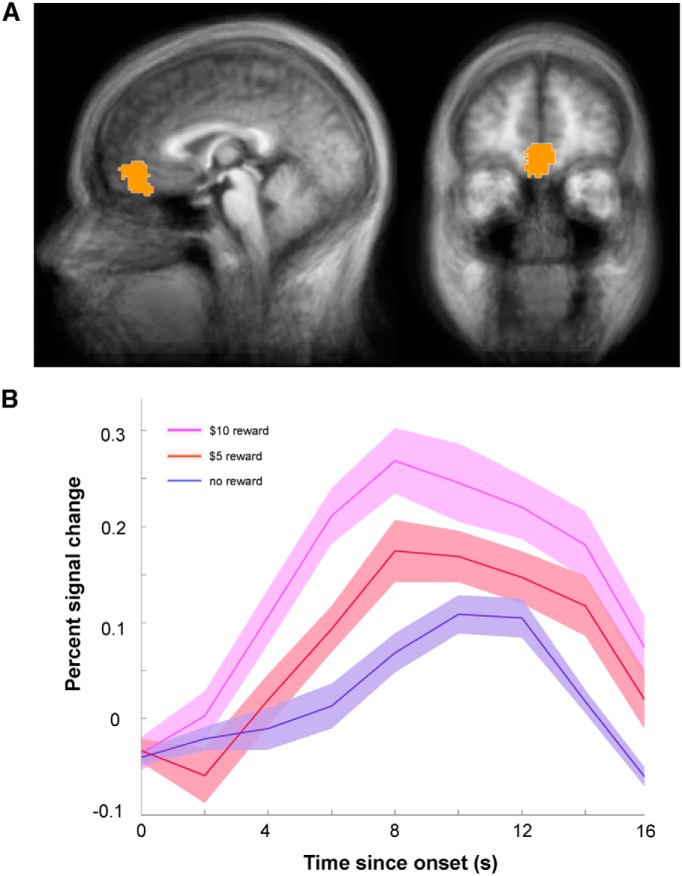
An independently defined value region in the vmPFC represents reward magnitude throughout the task. A, The spatial location of the external ROI. The ROI was reported by a meta-analysis on the valuation system in the human brain (Bartra et al., 2013) and made available through the authors’ website (http://www.psych.upenn.edu/kable_lab/Joes_Homepage/Resources.html). B, Average percentage signal change in the activity of the ROI for $10 reward, $5 reward, and no reward. Activity was significantly modulated by outcome magnitude (p = 0.039). Post hoc Tukey tests revealed significant (or marginally significant) differences between no reward and $5 reward (p = 0.051), between no reward and $10 (p = 0.020), and between $5 and $10 (p = 0.008).